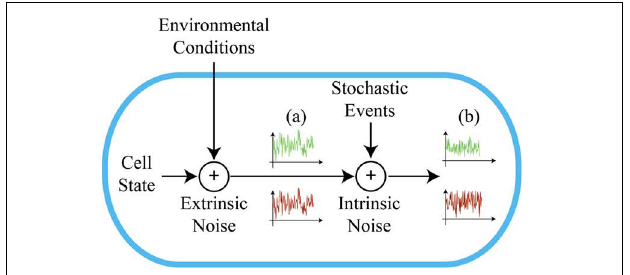
FIGURE 1 | Intrinsic and extrinsic components of noise. Extrinsic noise results from changes in the environmental conditions and cellular state. This contribution equally affects two fluorescence reporter proteins transcribed from the same promoter (a). Their expression is modulated in an uncorrelated way by intrinsic noise, due to the stochasticity of biochemical events